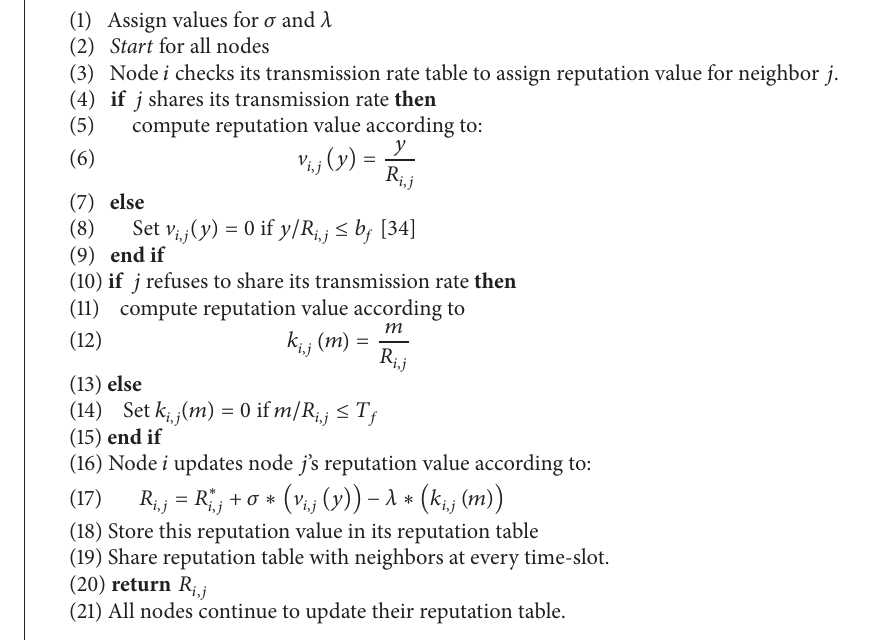
Algorithm 2: Coalition maintenance through